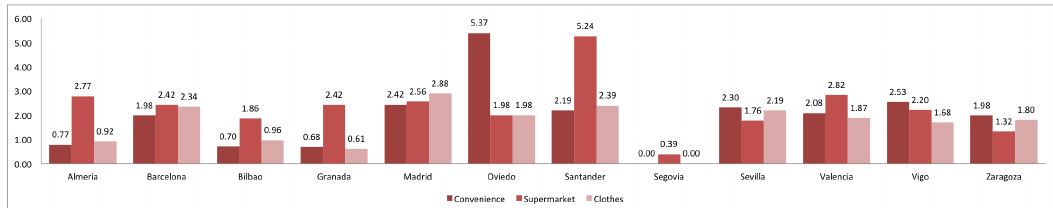
Figure 9. Consistency study of highway in Spain. Standard deviation of tag number.